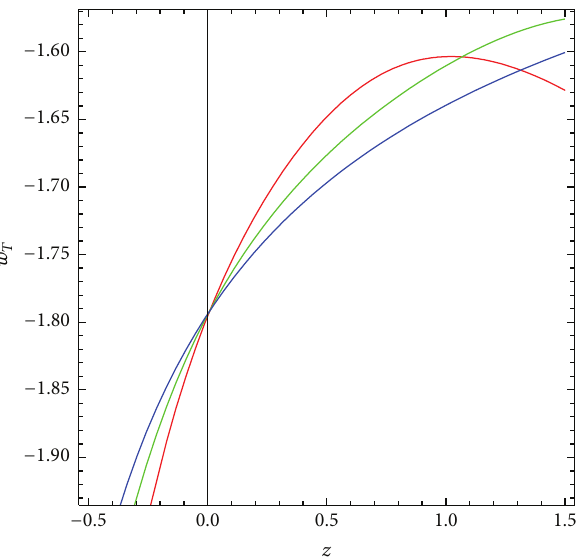
using (63) in tot